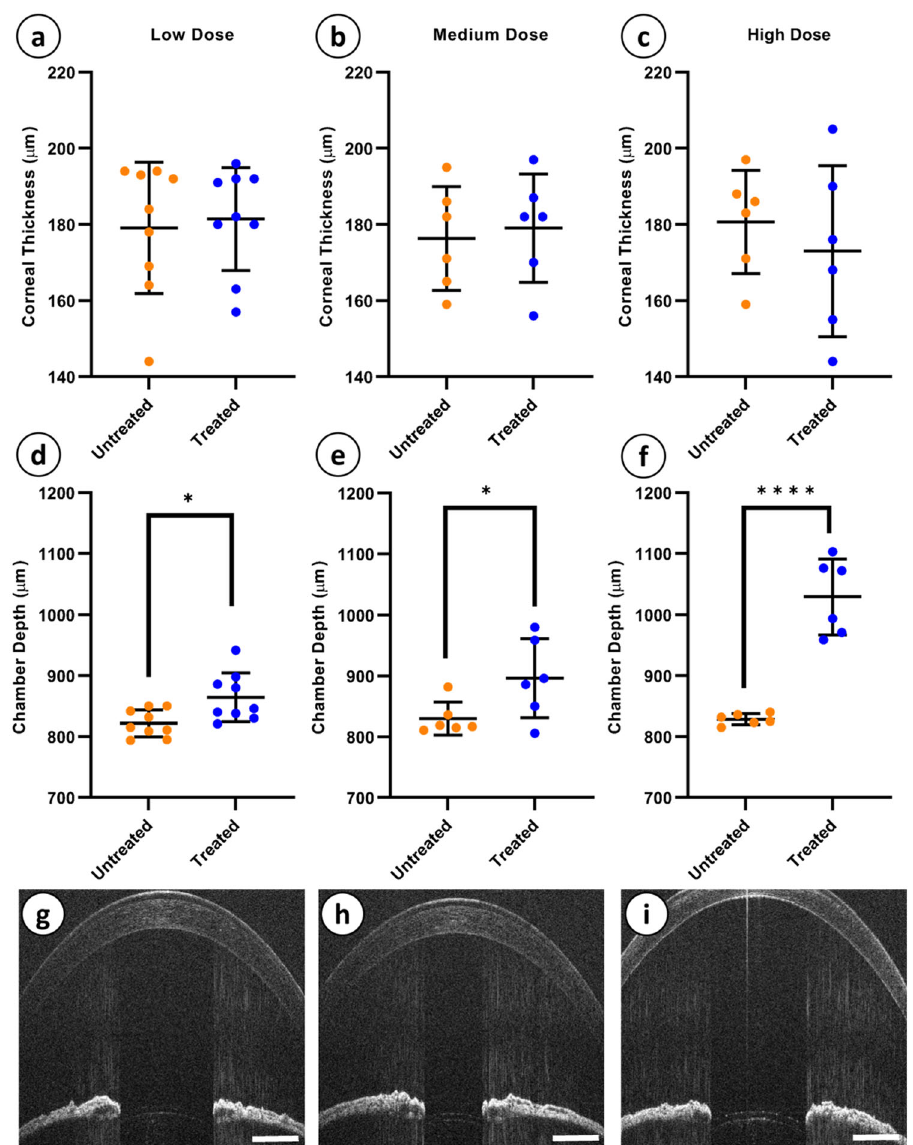
Fig. 5 Central corneal thickness and anterior chamber depth of treated and untreated eyes at each dosage. Central corneal thickness was not signi fi cantly changed between untreated and treated eyes of any dosage group ( a – c ). Anterior chamber depth was found to be signi fi cantly increased in low ( d , g ), medium ( e , h ), and high ( f , i ) dose treated eyes as compared to untreated controls. (Unpaired T-test: p = 0.7541 ( a ), p = 0.0447 ( b ), p =